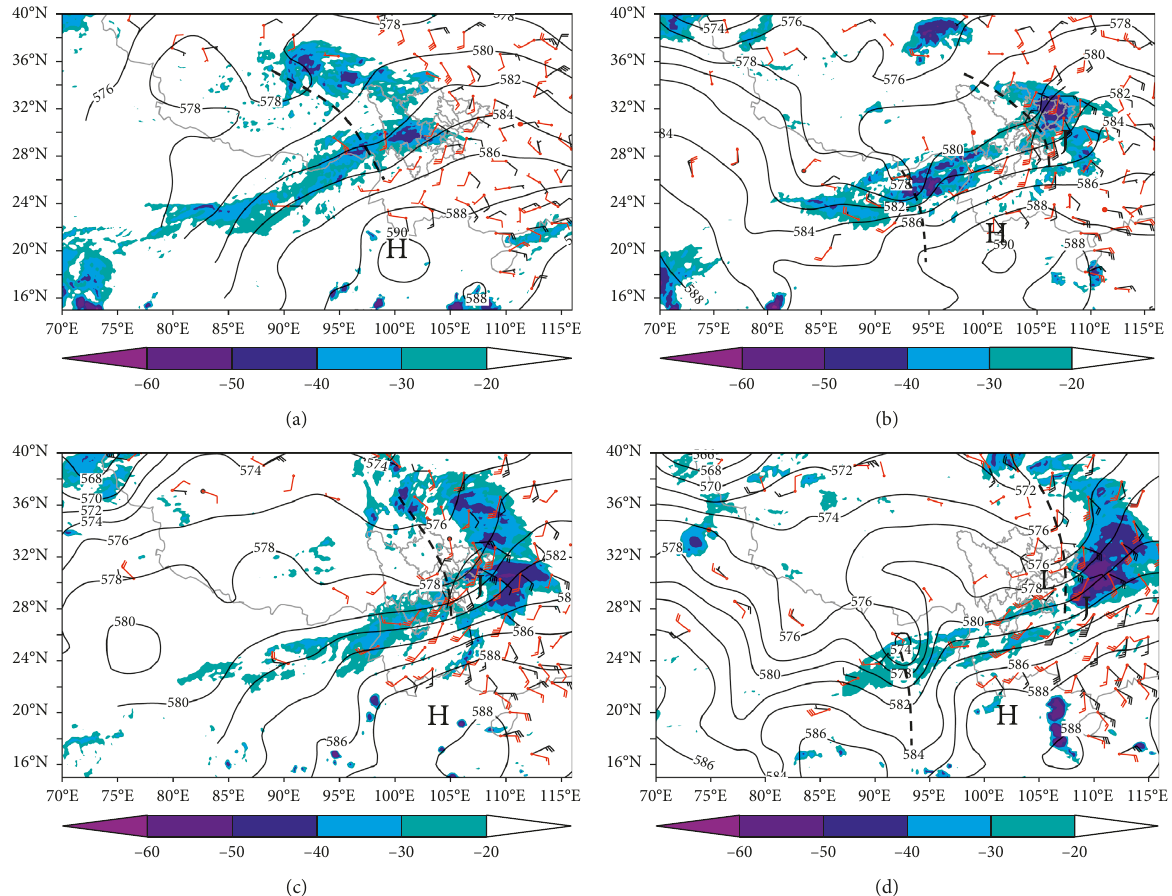
1 ), 850hPa wind field (black, m s · −